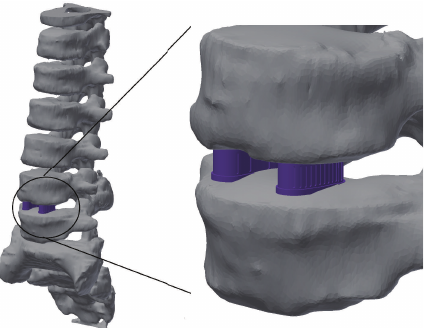
Figure 1: Representation of the lumbar cage implants (vertebrae images courtesy of Centro de Tecnologia da Informac¸˜ao Renato